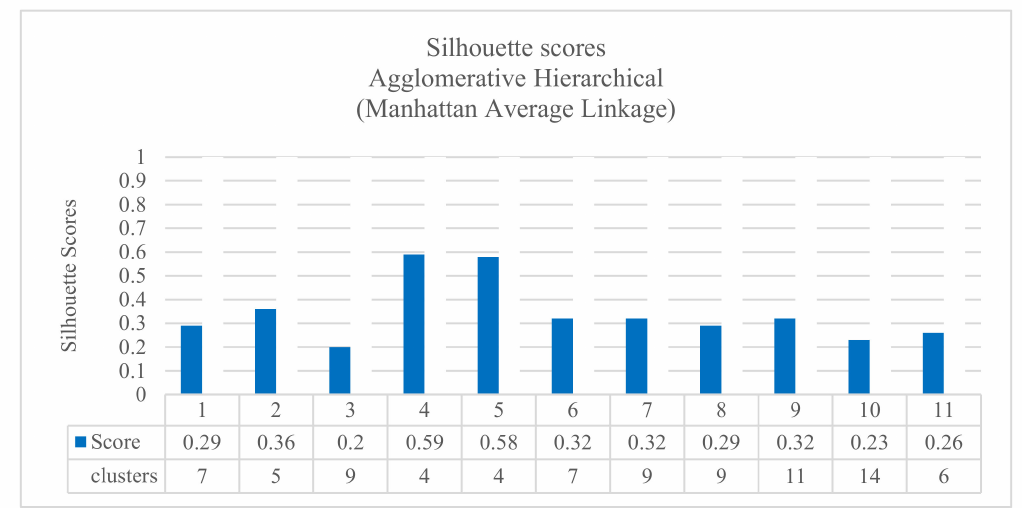
Figure 5. The results of Silhouette scores for agglomerative hierarchical Manhattan average linkage.